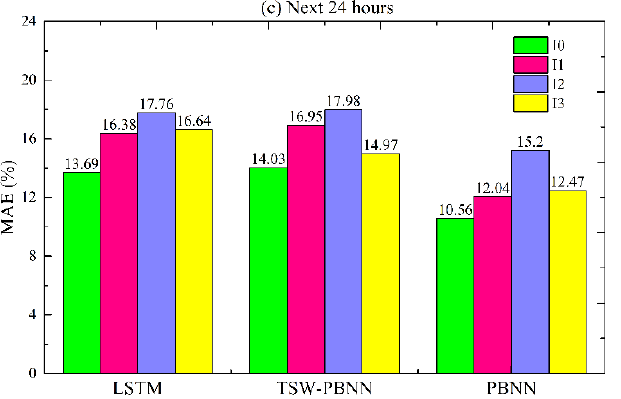
Figure 14. Prediction error of LSTM, TSW-PBNN, and PBNN on different training